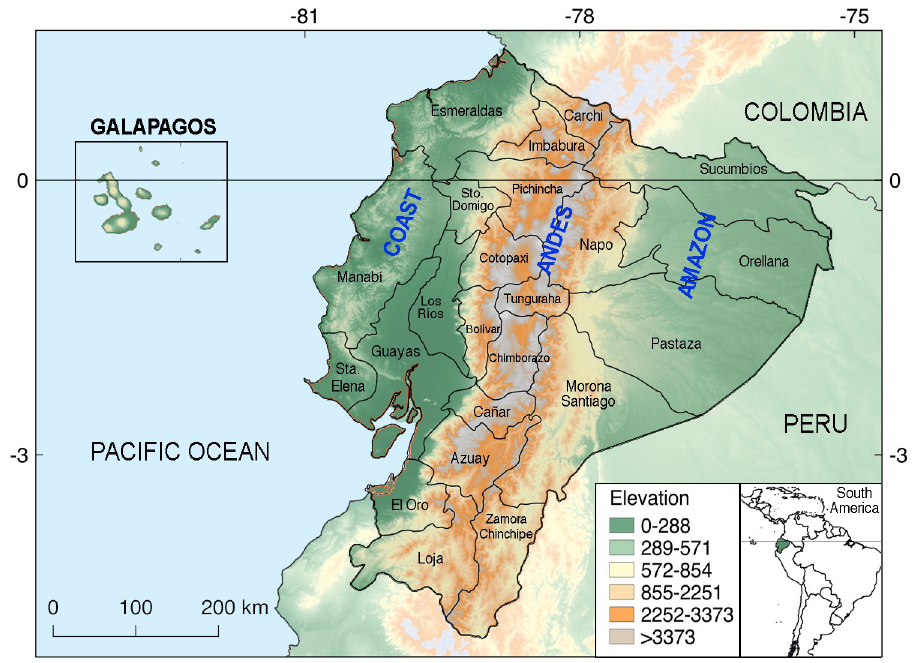
Fig 1. Geographic map of Ecuador. Administratively, Ecuador is divided in 24 provinces containing 224 cantons with differing geographic, socioeconomic, and cultural characteristics. Seven provinces lie on the Coast, ten in the Andes, and six in the Amazon. The Galapagos Islands are in the Pacific Ocean at 1,369 km from the Ecuadorian coast and have dry and warm weather. Cantons are second-order administrative divisions, within the provinces. The map was created with QGIS 2.18. (Geographic Information System, Open Source Geospatial. Foundation Project. http://qgis. osgeo.org). The box to the upper left encloses the Galapagos Islands, while the box to the lower right provides a color- coded key to the land-elevation ranges within the